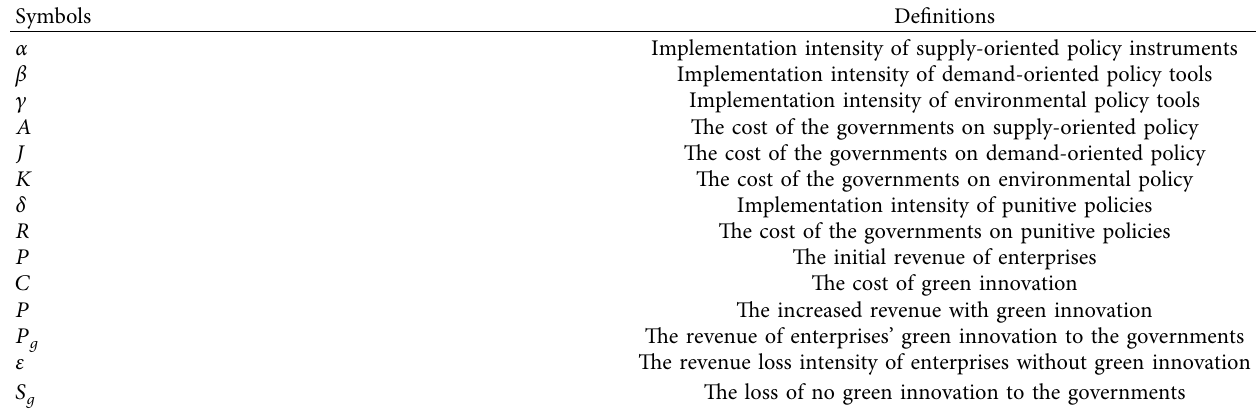
Table 1: Notations and